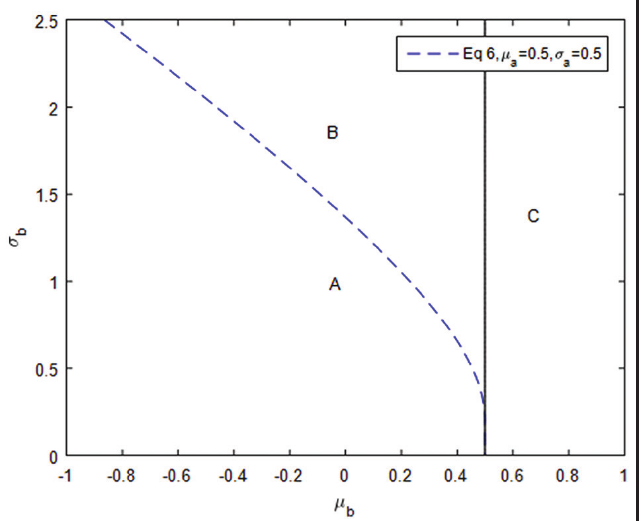
Figure 3 Substitution toward riskier applicants with trial